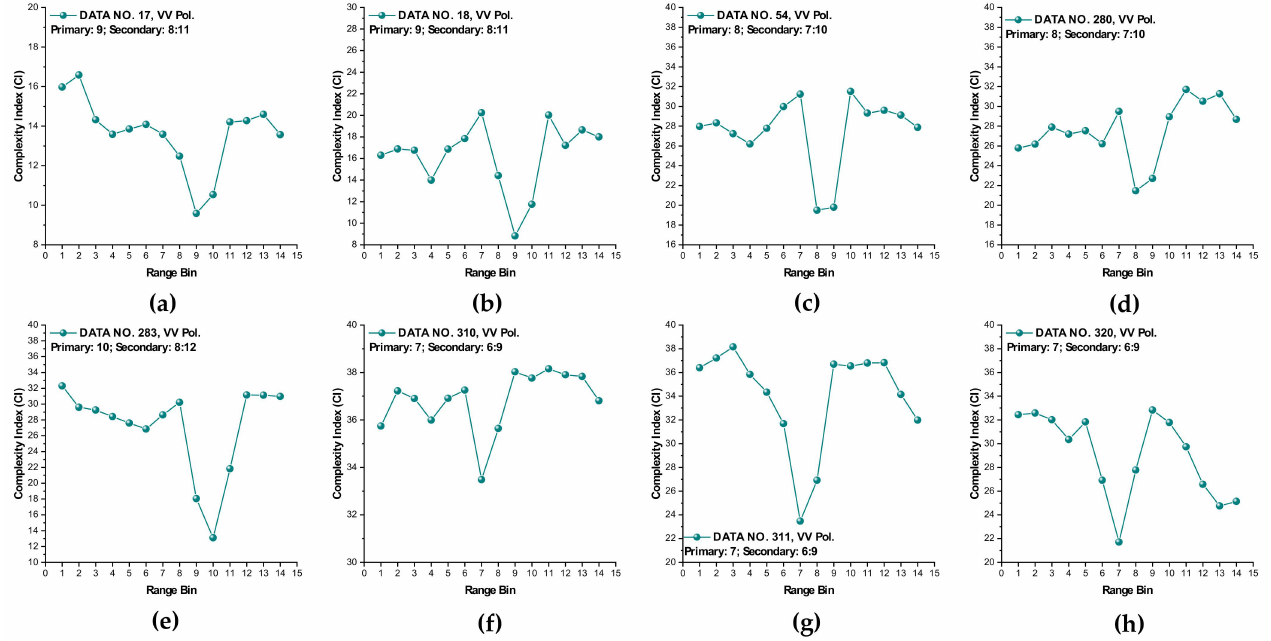
Figure 9. ( a – h ) Complexity indices of data sets 17, 18, 54, 280, 283, 310, 311, and 320 (VV polarization, under the same parameters as Figure